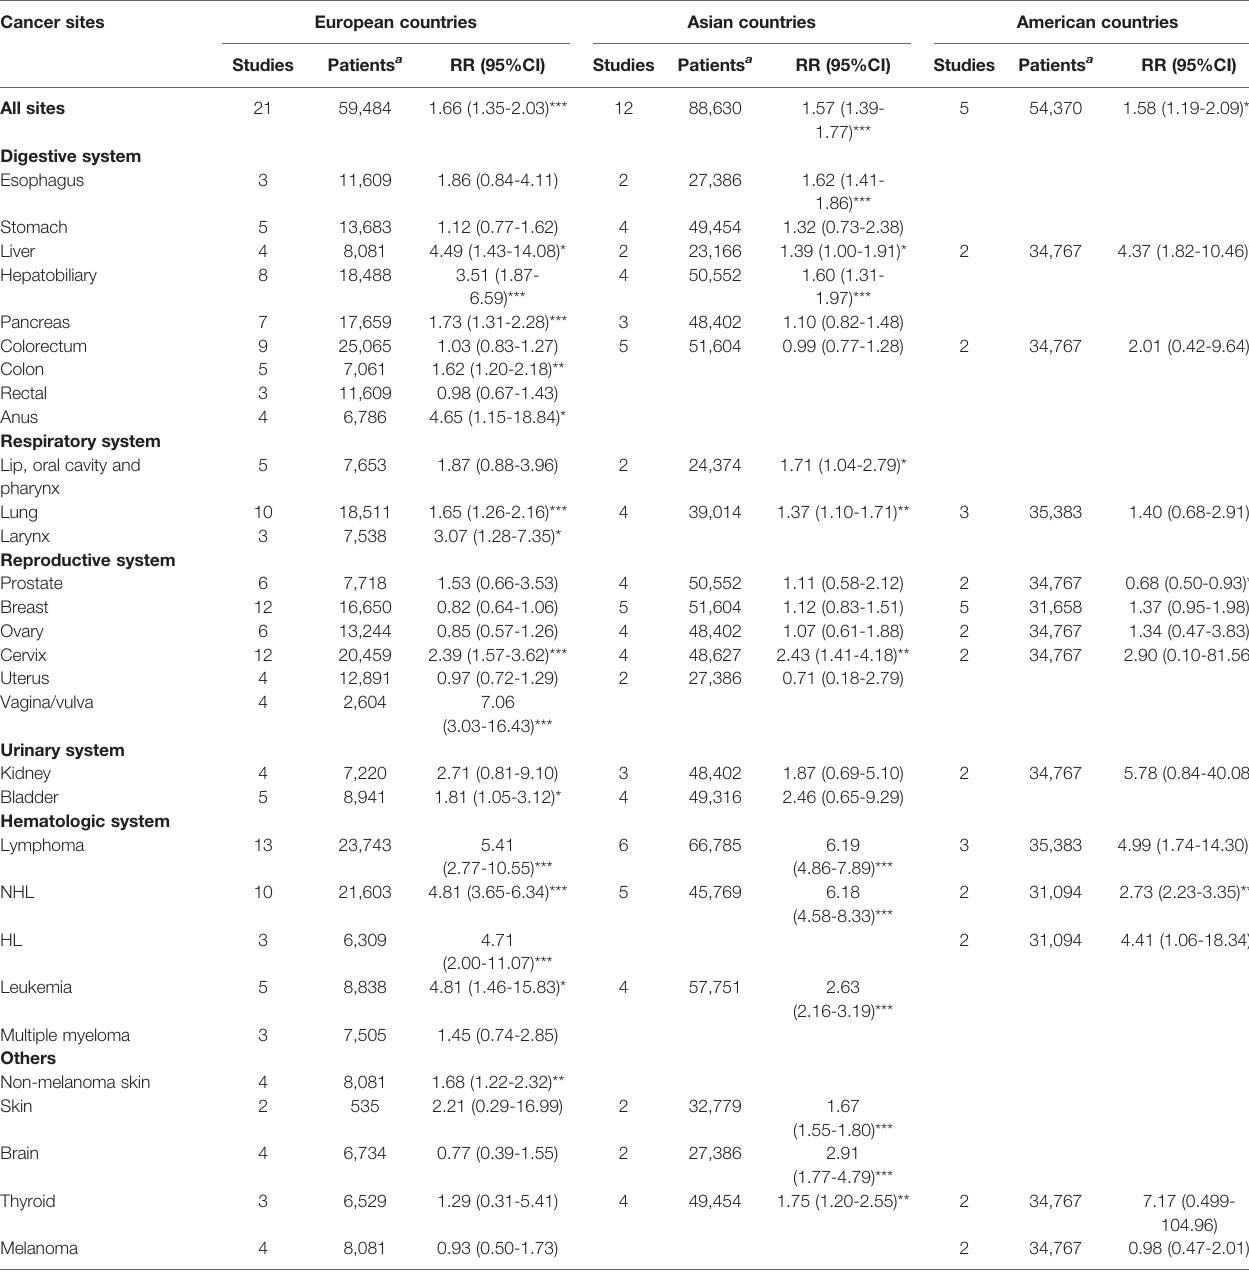
TABLE 2 | Results of Subgroup analysis by geographic region in the meta-analysis. Cancer